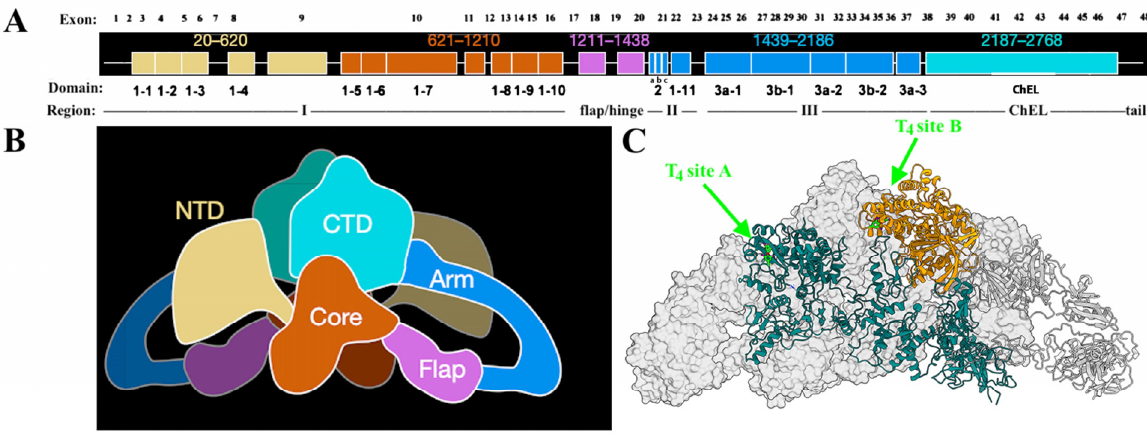
Figure 1. Thyroglobulin Organization (panel ( A ), exons listed above), Primary Structure (Panel ( A ), regions and domains shown below); Tertiary Structure from cryo-EM model (panel ( B )), and the two most-utilized T 4 formation sites (panel ( C ), in bright green).